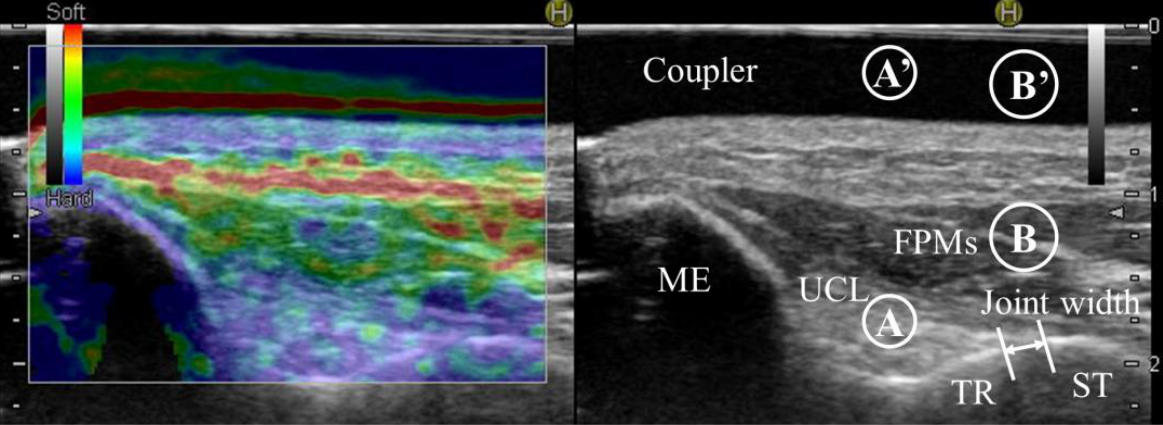
Figure 2. Evaluation of ultrasound images. The elastography image on the left is colored for each tissue hardness (red, soft; yellow to green, medium; blue, hard). The image on the right is a B-mode image. ME, medial epicondyle of humerus; TR, trochlea of humerus; ST, sublime tubercle of ulna; UCL, ulnar collateral ligament; FPMs, forearm flexor–pronator muscles; Coupler, coupler region; Joint width, ulnohumeral joint width; Circle A, target region of UCL; Circle A’, reference region of UCL (just above the UCL’s target region); Circle B, target region of FPMs; Circle B’, reference region of FPMs (just above the FPMs’ target region).